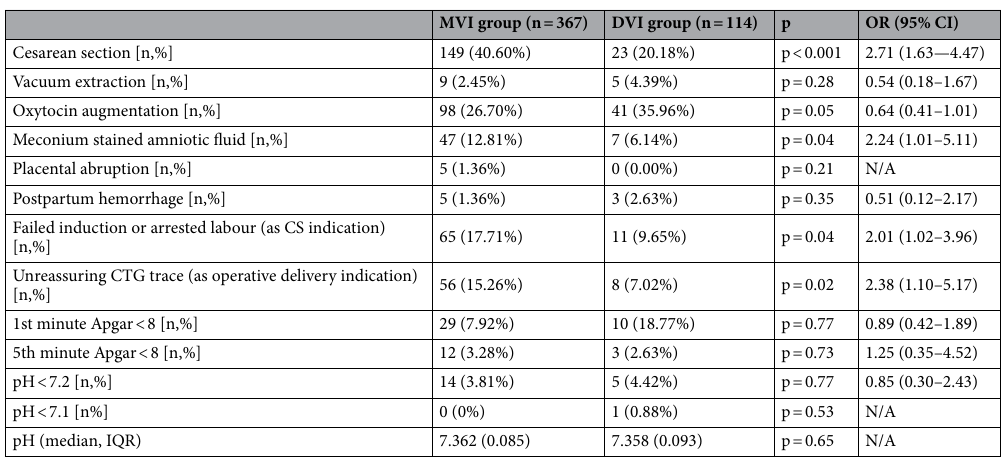
Table 3. Comparison of obstetrical and neonatological